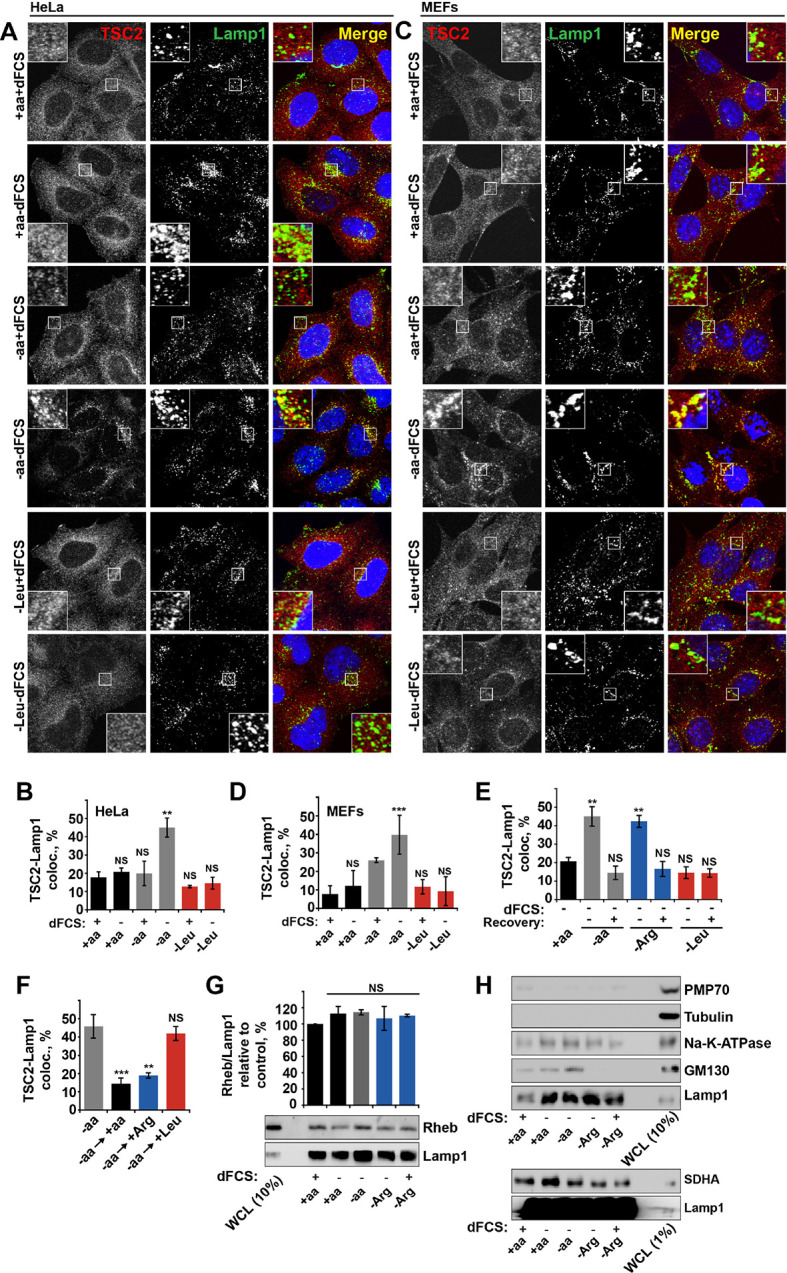
Arginine specifically regulates TSC2 localization to the lysosome.HeLa (A, B) and MEF (C, D) cells were starved of all amino acids or leucine in the presence or absence of dialyzed serum (dFCS) where indicated. Cells were fixed and immunostained with antibodies against TSC2 and Lamp1 (A, C). The percentage of co-localization between TSC2 and Lamp1 was quantified (B, D). (E) HeLa cells were starved of serum and all amino acids, arginine or leucine, followed, where stated, by recovery of amino acids. Cells were immunostained for TSC2 and Lamp1 and the percentage co-localization was determined. (F) HeLa cells were completely starved of amino acids followed by recovery with individual amino acids as indicated. Cells were fixed and stained for TSC2 and Lamp1 and the percentage ofTSC2-Lamp1 co-localization was quantified. (G–H) Rheb is a constitutive component of lysosomal membranes. HeLa cells were subjected to different starvation protocols as indicated prior to harvesting. Lysosomes were isolated and equal amounts of protein were analyzed by immunoblotting. Rheb detected in lysosomal preps was normalized to Lamp1 content (G). To check efficiency of lysosomal enrichment, immunoblotting was carried out for PMP70 (peroxisome marker), tubulin (cytoplasmic protein), GM130 (Golgi marker), SDHA (mitochondrial marker), and N+-K+-ATPase (as a marker for the plasma membrane) (H). Scale bars: 10 μm. Nuclei are visualized in merge images with TO-PRO-3 iodide. All graphs with statistics represent an average of at least three independent experiments and error bars represent s.e.m except D where error bars represent s.d. *p<0.05, **p<0.01, ***p<0.005. NS: not significant.; WCL: whole-cell lysate.